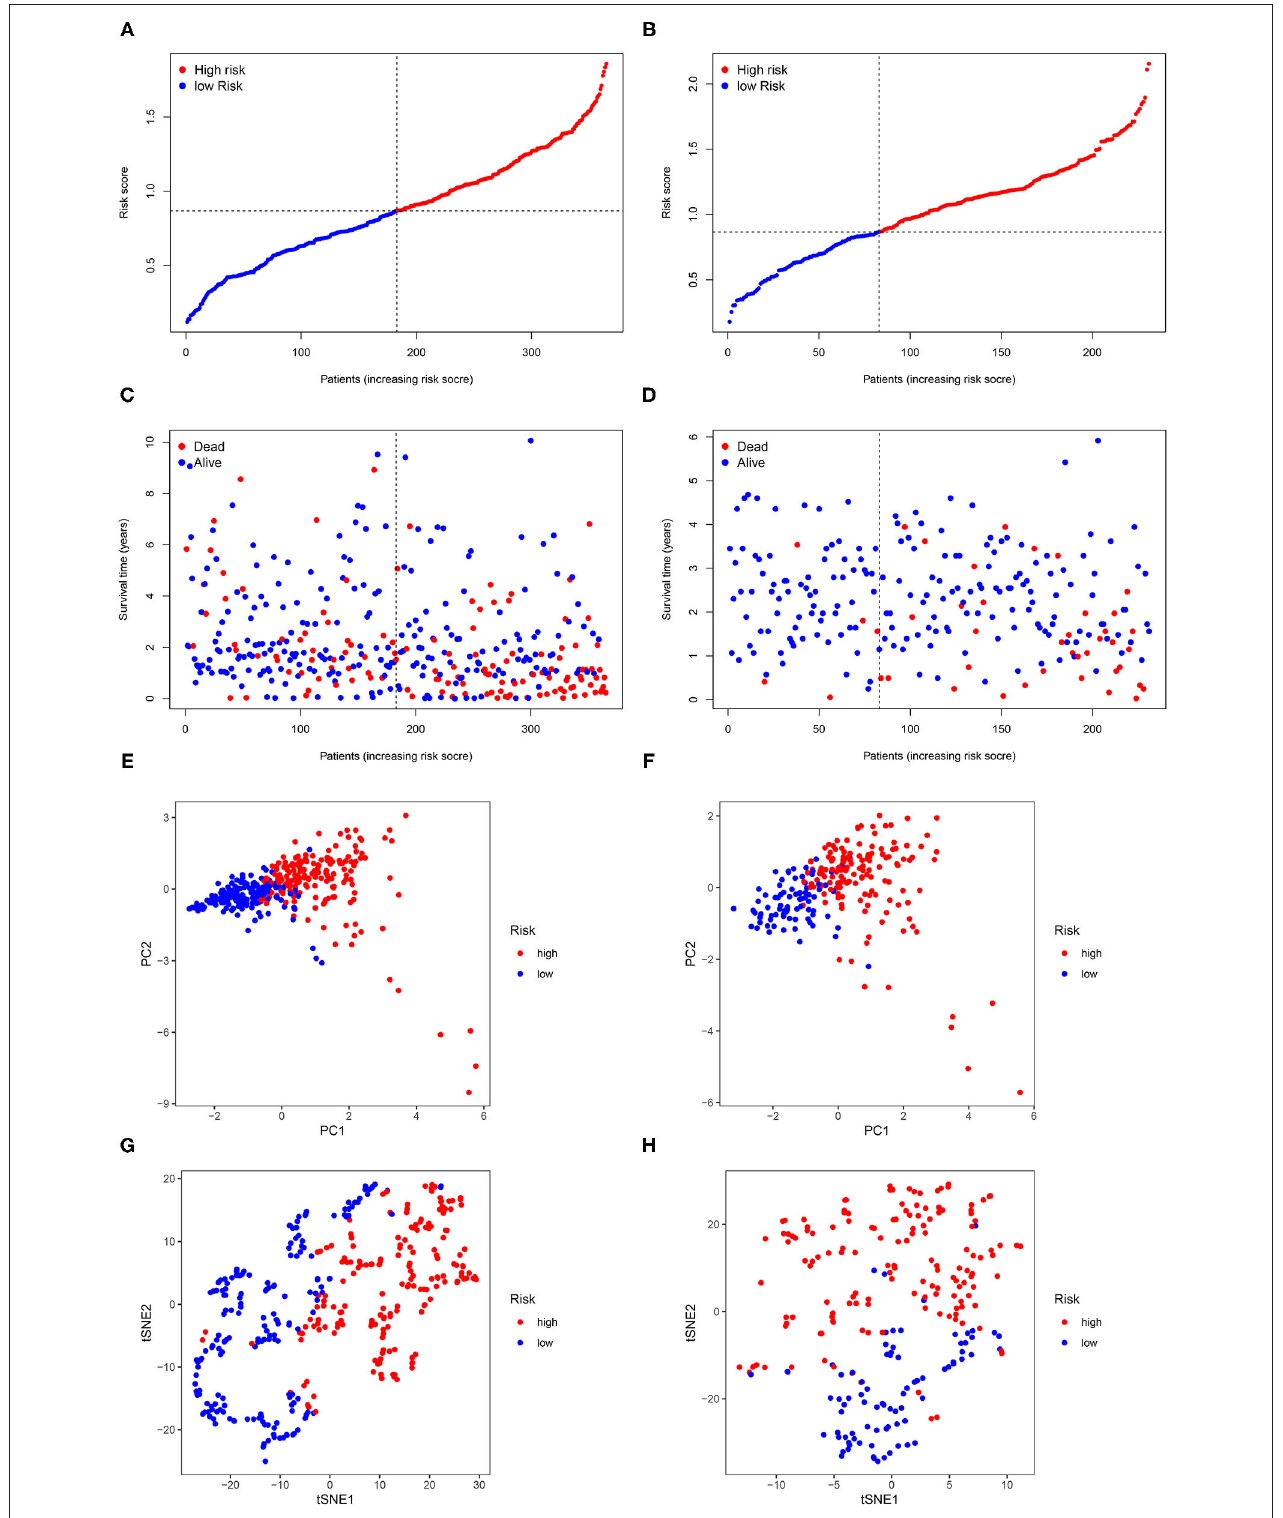
FIGURE 4 | The risk score and survival time distribution of each patient. Risk score distribution in (A) the TCGA dataset and (B) the ICGC dataset. Survival time distribution in (C) the TCGA dataset and (D) principal component analysis (PCA) in (E) the TCGA dataset and (F) the ICGC dataset. t-statistic stochastic neighborhood embedding (t-SNE) in (G) the TCGA dataset and (H) the ICGC dataset.